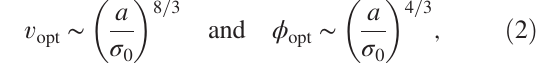
ffiffiffiffiffiffiffiffiffiffiffiffiffiffiffiffiffiffiffiffiffiffiffiffiffiffiffiffiffiffiffi p 4 þ 1 4 ϕ 2 σ 0 =a Þ 0 ð